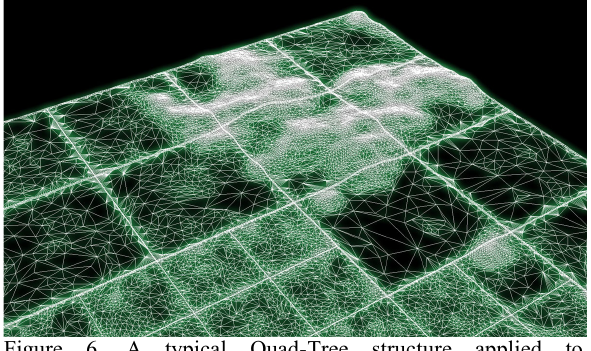
Figure 6. A typical Quad-Tree structure applied to Montegrotto terrain